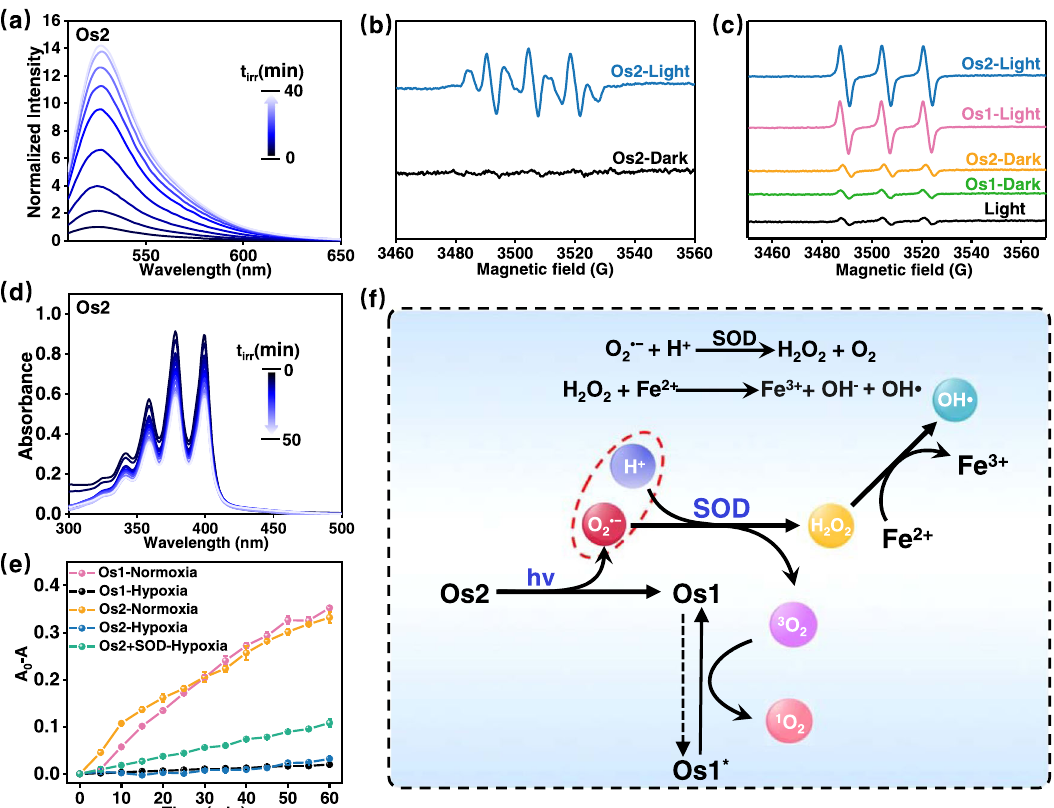
Fig. 2 Detection of ROS in solution. a The emission spectra for monitoring O 2 (cid:129) − generation by Os2 (10 μ M) using DHR123 probe (10 μ M, λ ex = 488 nm) in normoxia. b The ESR signal of O 2 (cid:129) − trapped by DMPO (18 mM) after light irradiation in normoxia. c The ESR signal of 1 O 2 trapped by TEMP (8 mM) after light irradiation in normoxia. d The UV – Vis absorption spectra of ABDA (100 μ M) for monitoring of 1 O 2 generated by Os2 (20 μ M) under light irradiation in normoxia. e The plot of A 0 -A of ABDA at 378 nm versus irradiation time in the presence of Os1 or Os2 in hypoxia or normoxia ( n = 3 independent experiments). Error bars represent S.D. from the mean. f Schematic diagram of generating O 2 (cid:129) − , 1 O 2 and OH (cid:129) by light-activating Os2 . Light irradiation: 465 nm, 13 mW/cm 2 ; Experiment temperature: 298 K; SOD superoxide dismutase.